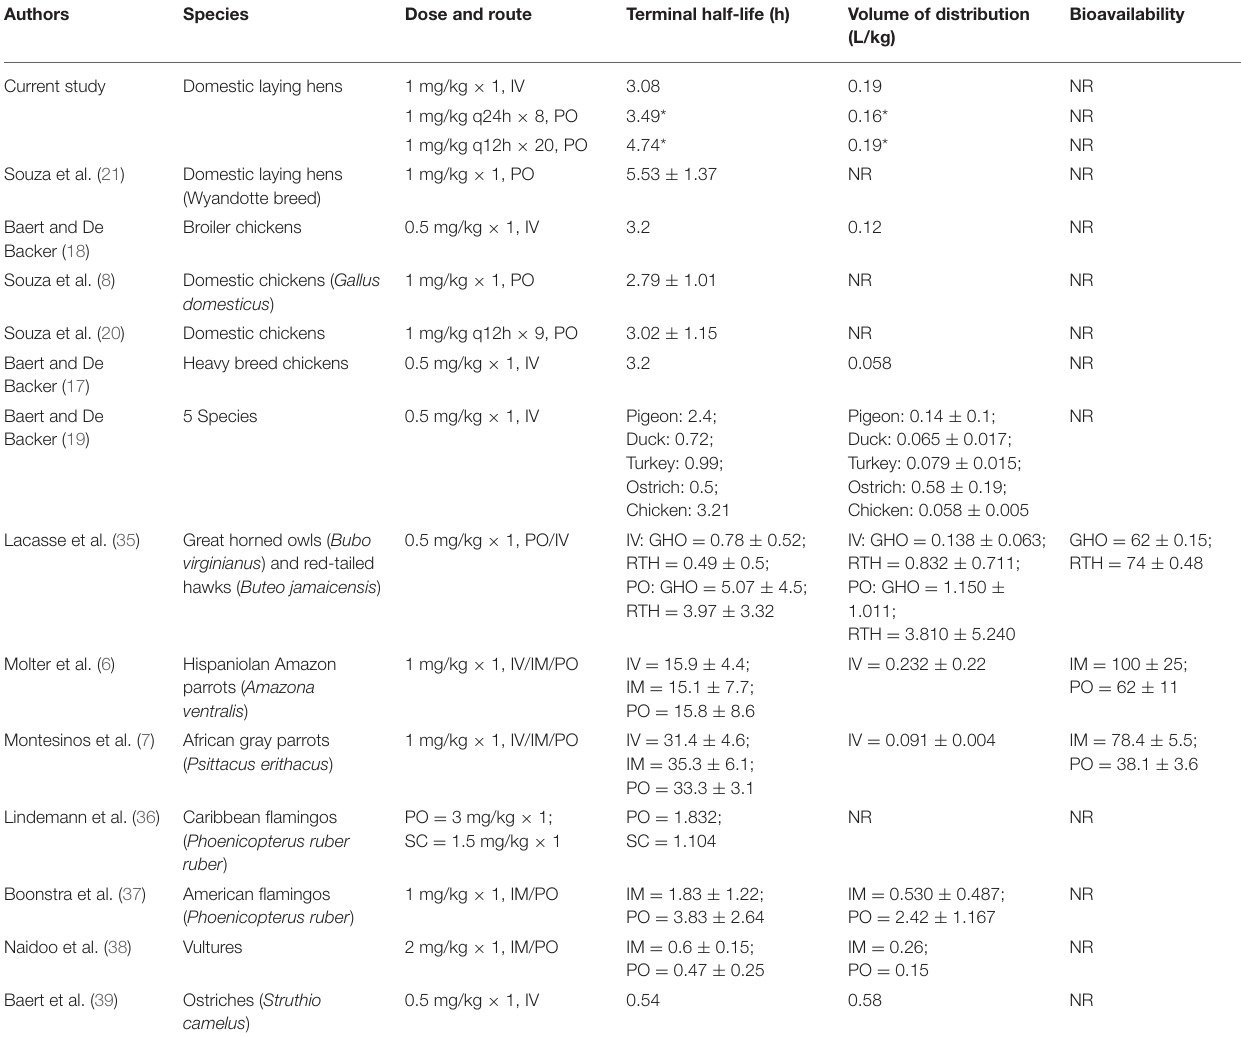
TABLE 7 | Previously published pharmacokinetic meloxicam studies in various avian